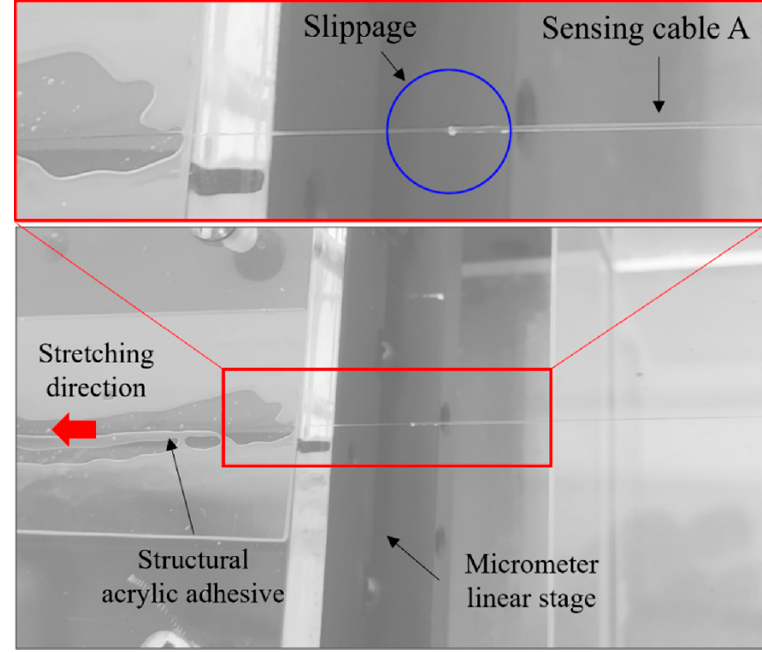
Figure 4. The acrylate layer peeled off from the core of sensing cable A.